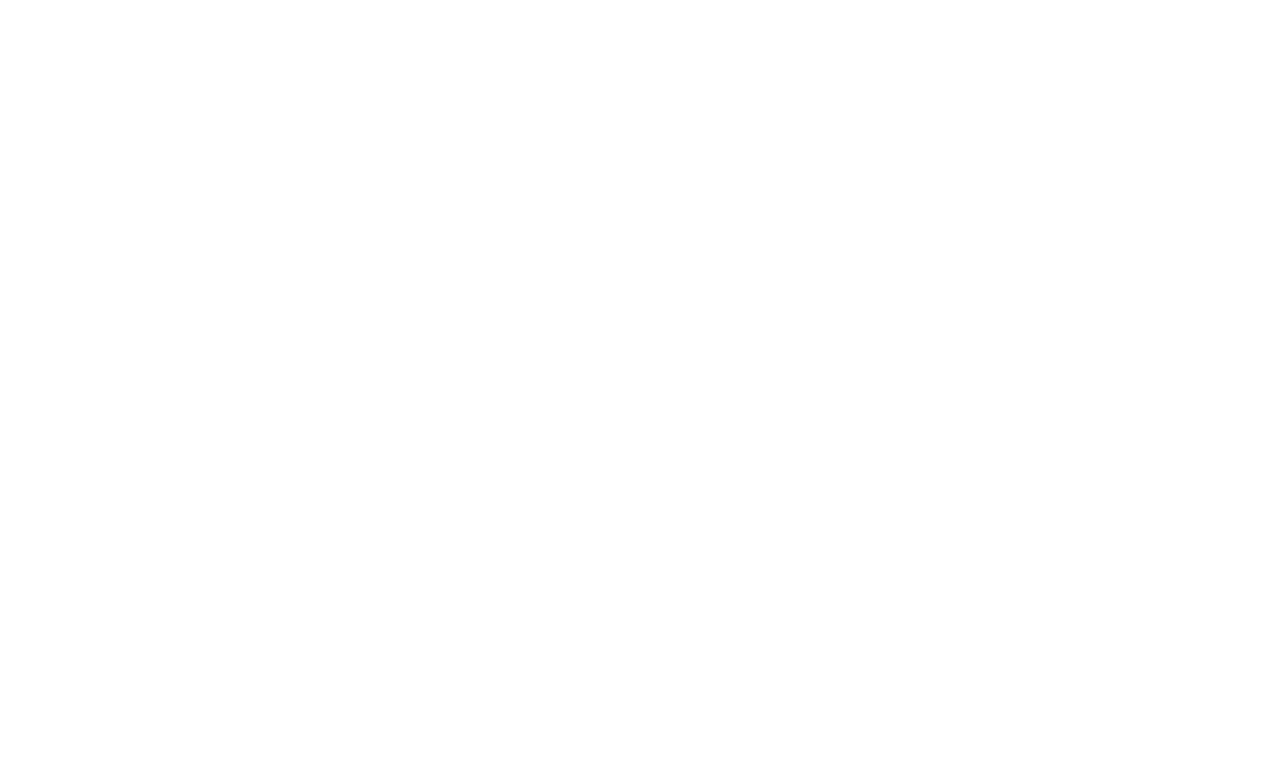
Frontiers in Environmental Science |